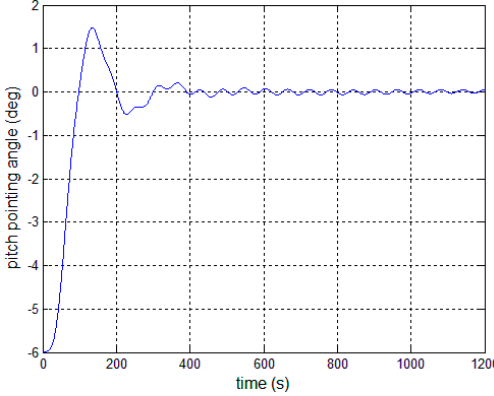
Figure 6. Antenna pitch angle error—controller (13).